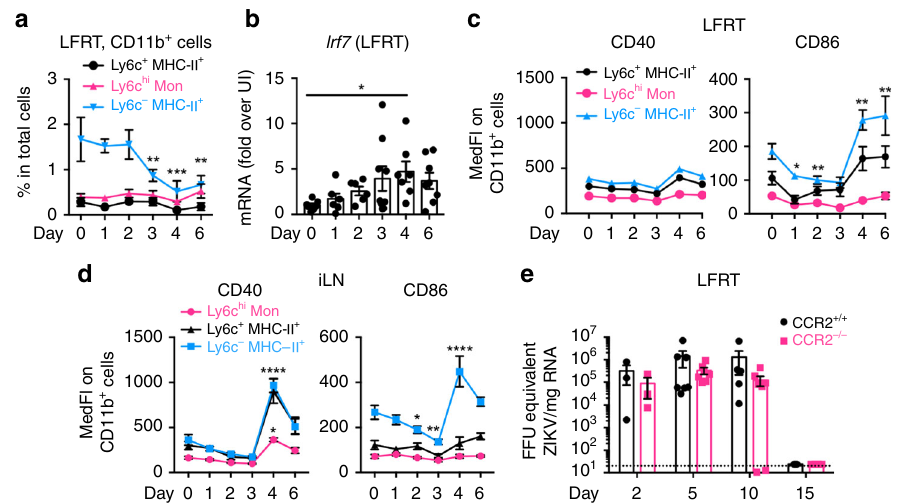
Fig. 2 Innate immune activation is delayed after intravaginal infection with ZIKV. Groups of DMPA-treated female mice were i.vag. inoculated with 2 × 10 4 FFU of ZIKV (PRVABC59). a Frequencies of various monocyte subsets in the LFRT post-infection. CD11b + cells: CD19 − TCR β − EpCAM-1 − Ly6G − CD11b + Ly6c + / − IAIE + / − . Also see Supplementary Fig. 2 for gating strategy. b Detection of Irf7 induction by qRT-PCR from LFRT total RNA at indicated time- points. Surface expression of activation markers on CD11b + cells in c LFRT and d iLN, as determined by fl ow cytometry. e FFU equivalents of ZIKV in total RNA from LFRT tissues of CCR2 − / − and CCR2 + / + animals were determined by qRT-PCR. Data pulled from two ( a , c , d , and e ) or three b independent experiments; mean ± SEM, n = 3 (day 2 in e), 3 – 4 (day 15 in e), 4 (days 4 and 6 in a , c and d ), 6 (days 0 – 3 in a , c , d , and day 1, 2 in b ), 7 (day 0 and 4 in b , day 5 and 10 in e ), 8 (day 6 in b ), or 9 (day 3 in b ) mice per time-point. * p < 0.05, **** p < 0.0001; two-way ANOVA with Dunnett ’ s multiple comparison test. Each time-point represents data from a separate group of mice, and day 0 represents data from uninfected mice. Source data for Fig. 2a – d are provided as a Source Data fi le